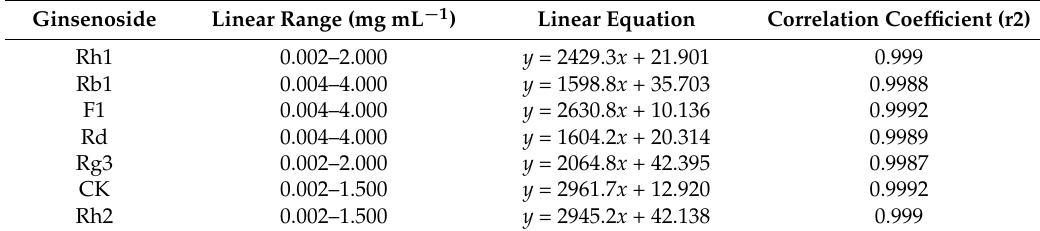
Table 1. The standard curve of ginsenosides, x represents the concentration of ginsenoside, y represents the peak area of